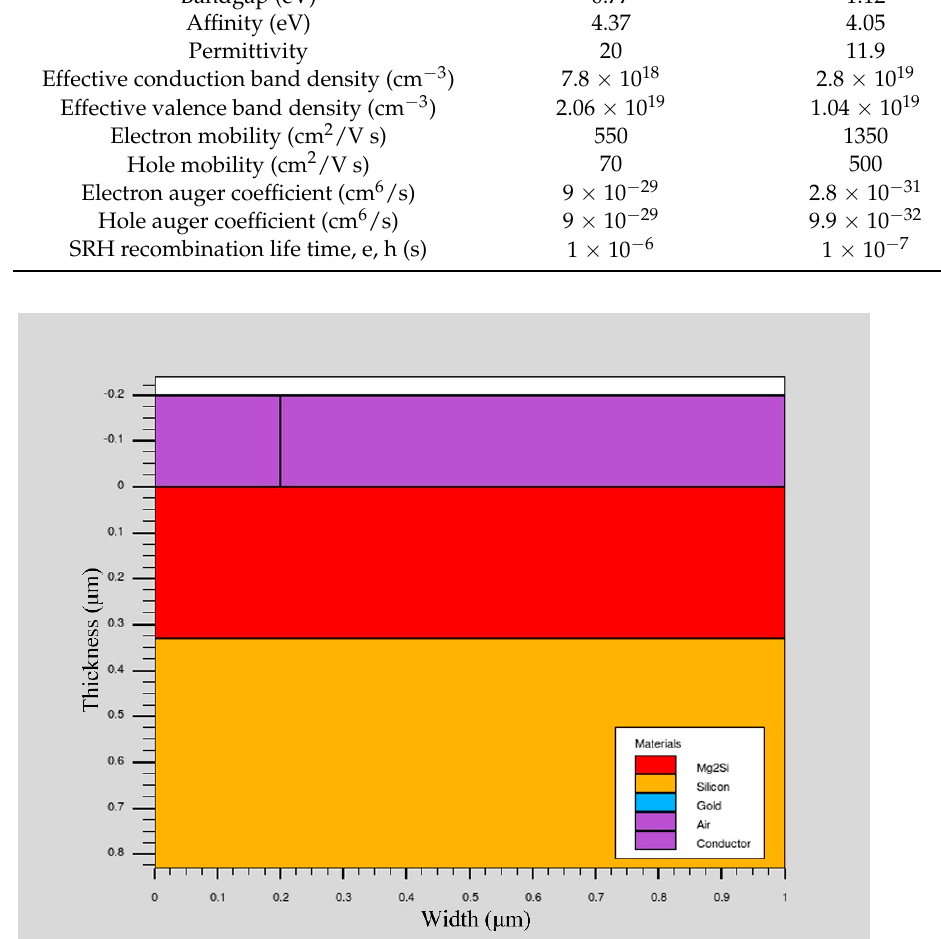
Figure 2. The cross–section of the Mg 2 SiSi heterojunction PD.